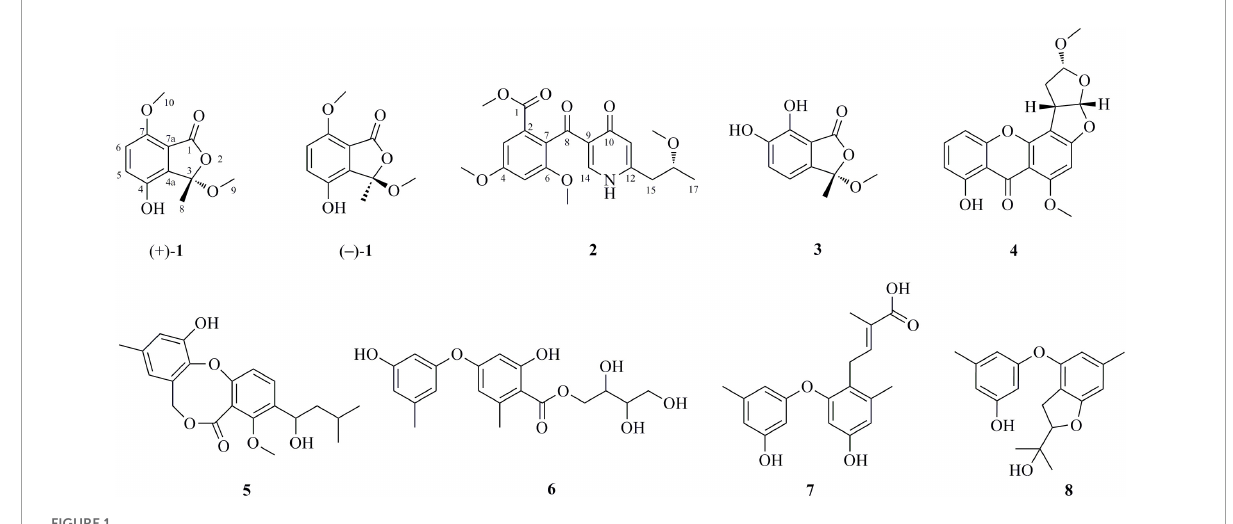
FIGURE1 Structures of the isolated compounds 1-8